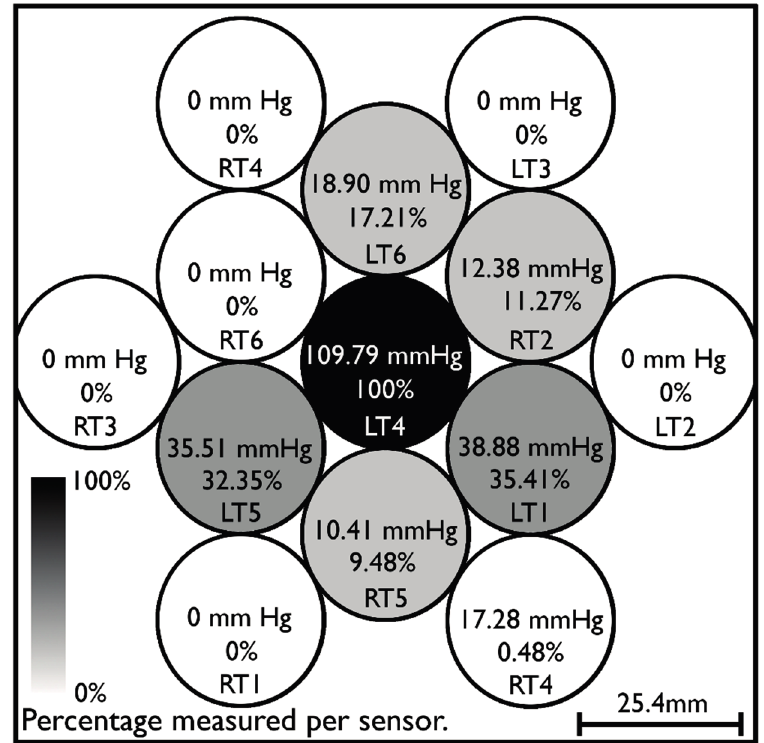
Figure 3. Distribution of pressure over 13 sensors due to cushioning pad. Pressure of 445.3 mm·Hg was applied directly over LT4 sensor (5.067 cm 2 ) in the